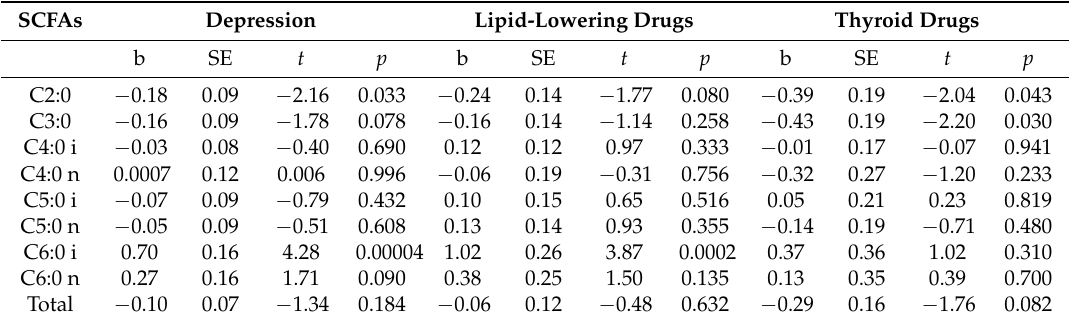
Table 4. Linear regression of SCFAs on depression status, the use of lipid lowering drugs and thyroid drugs.